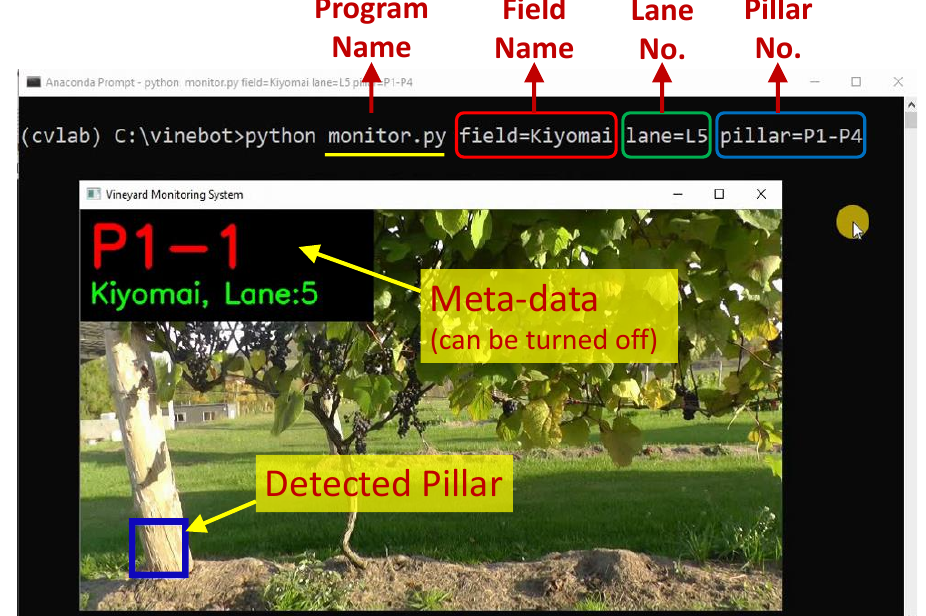
Figure 12. A snapshot of monitoring